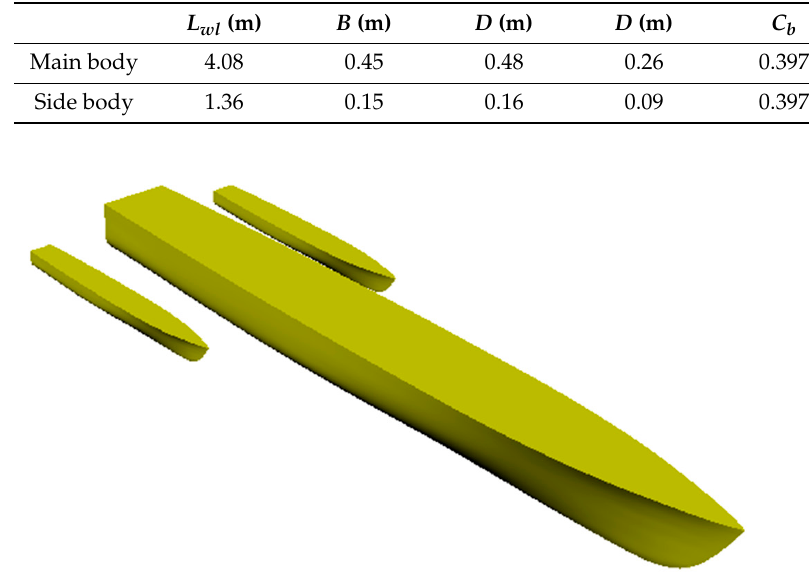
Figure 10. 3D model of the initial ship.